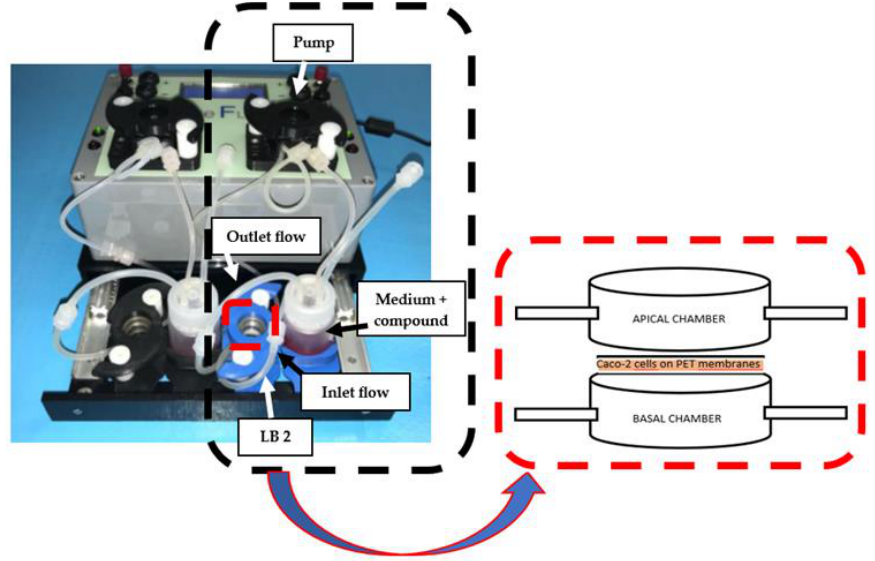
Figure 2. LiveFlow ® bioreactor in our